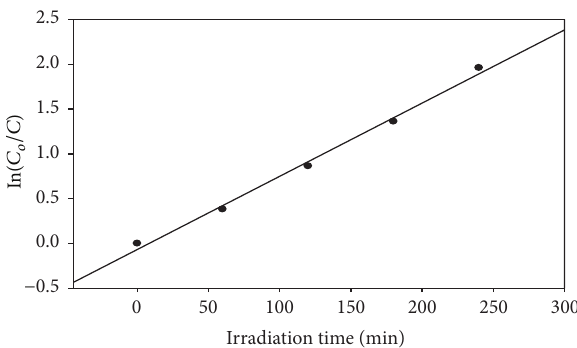
Figure 11: Plot of In (𝐶 𝑜 /𝐶) versus irradiation time.